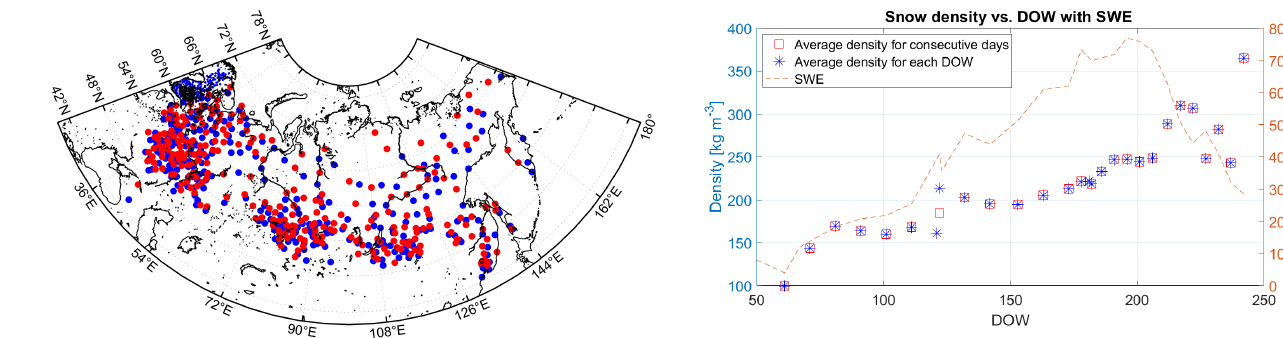
Figure 1. Locations of Eurasian snow courses divided into two sets: implementation (red) and validation (blue).